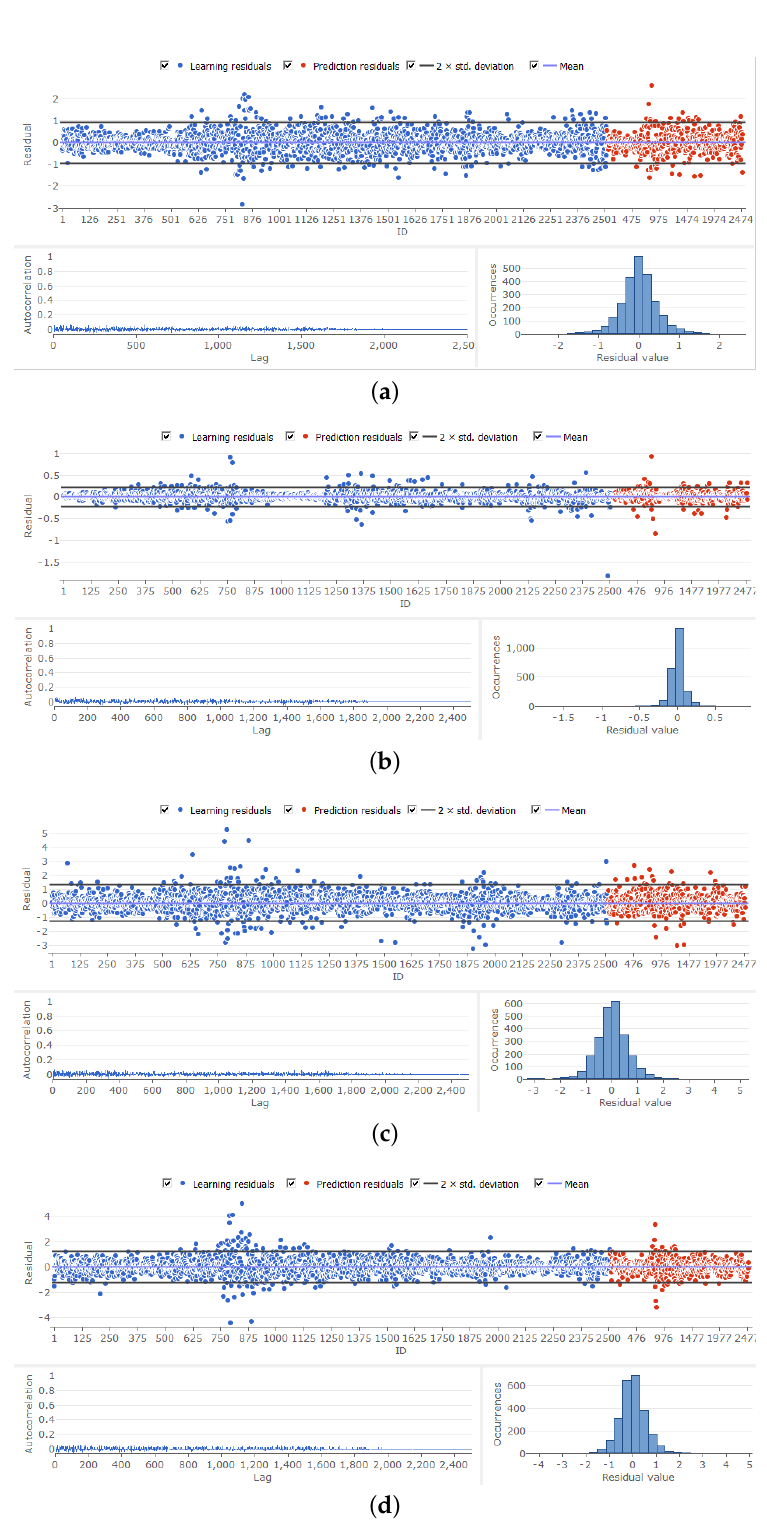
Figure 5. Residual plots Neural Network Regression Analysis; ( a ) Euro; ( b ) China; ( c ) Japan; ( d ) UK. Plots of the residuals are shown in Figure 5. These reveal that the models behave reasonably well, in that the autocorrelation of residuals is of a low order, and the histograms of the residuals are unimodal. There is a clustering of observations in excess of two standard errors from the model